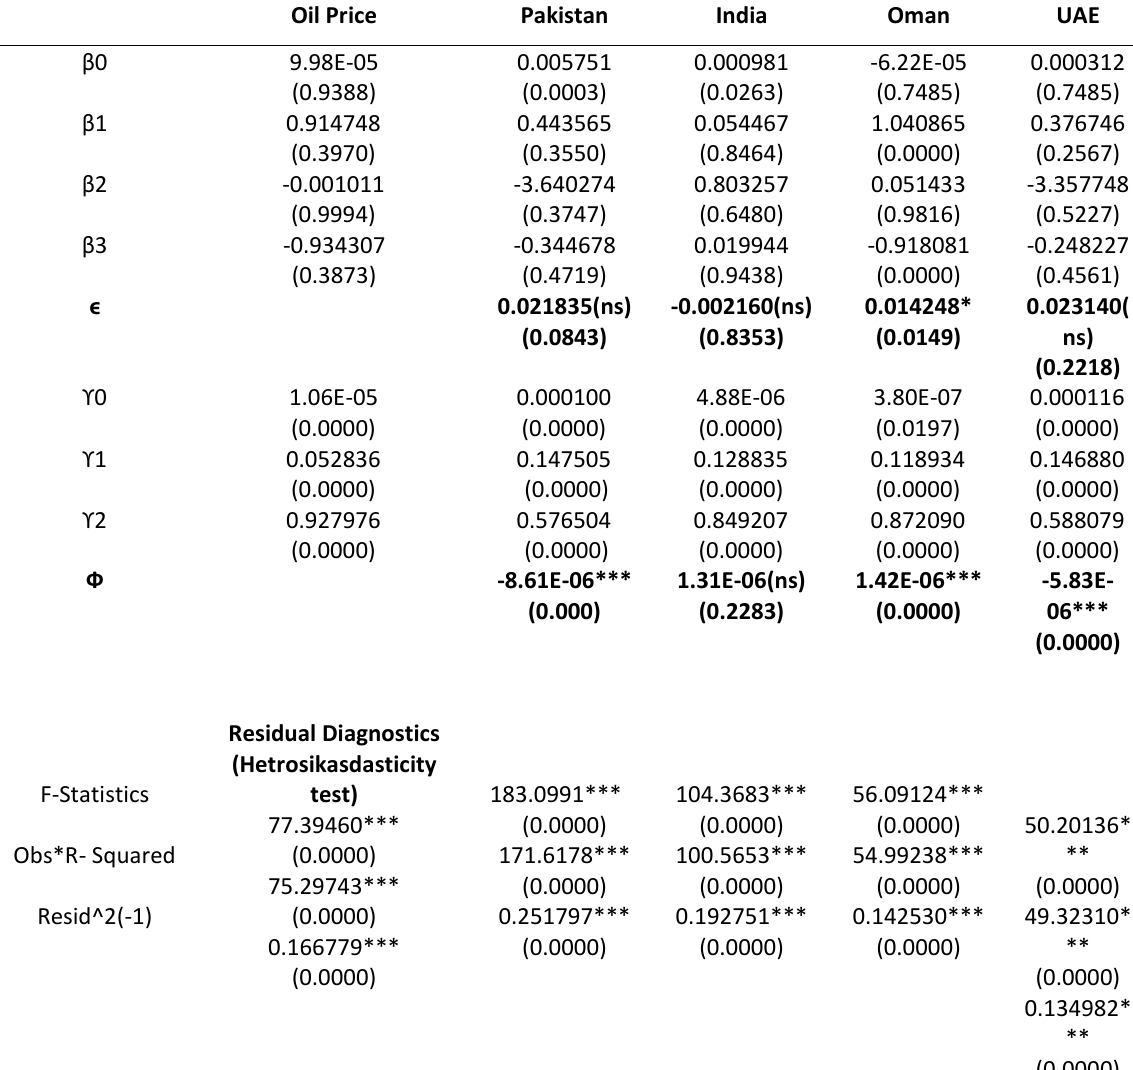
Table 4. Mean and Volatility spillovers from Oil Market Price to Pakistan, Indian, Oman and UAE